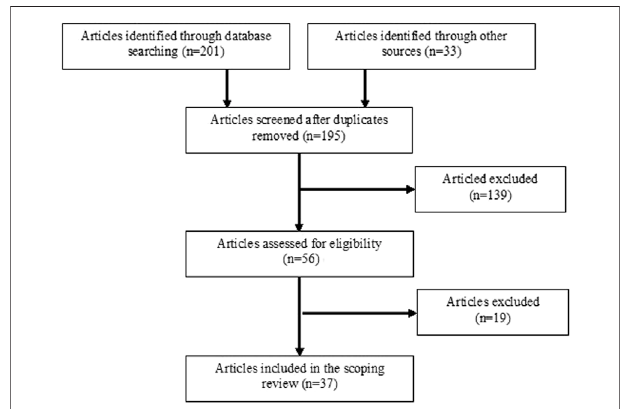
FIGURE 1 | A fl owchart showing phases of the literature